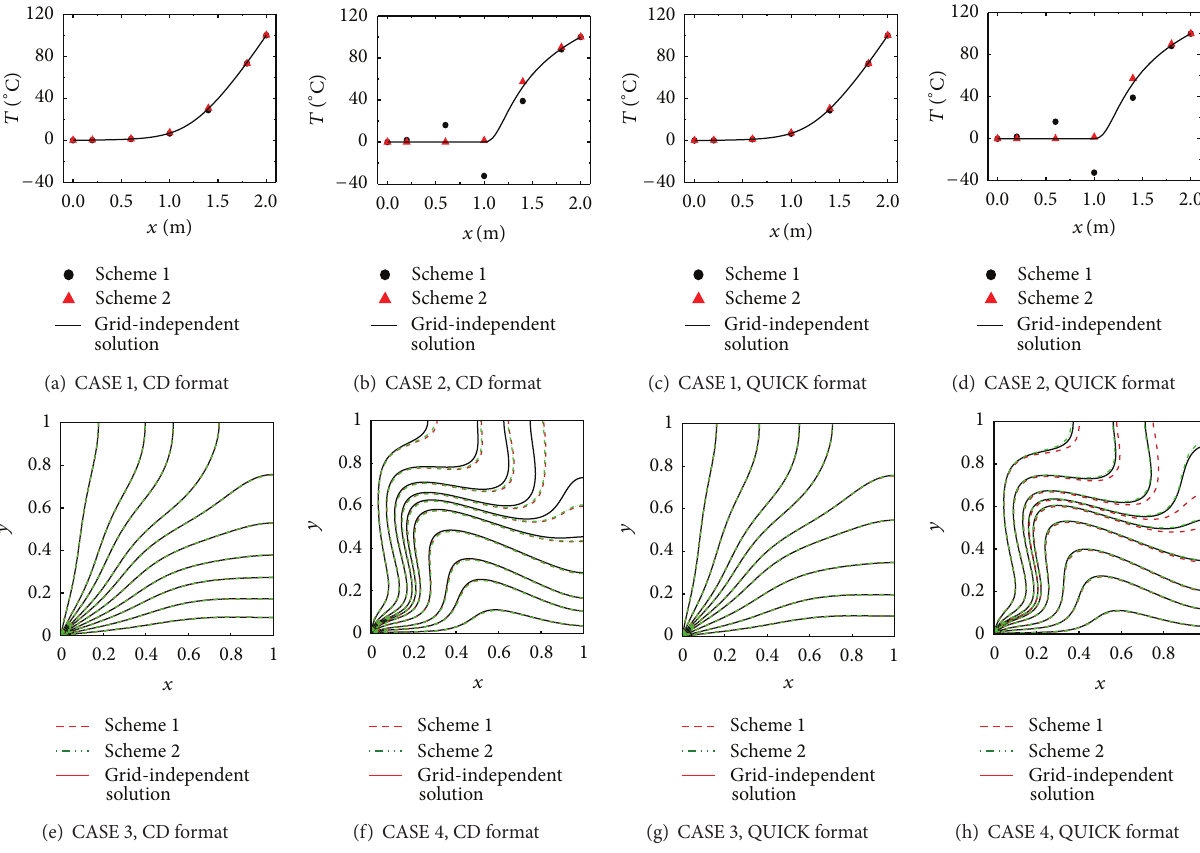
Figure 4: Comparison of different evaluations of the convective